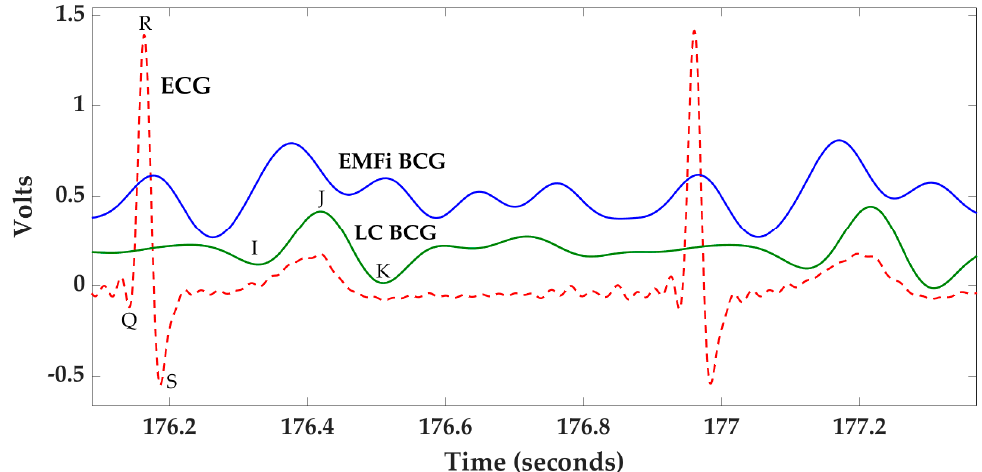
Figure 1. Two sample ballistocardiograms (BCGs) acquired with a bed system using electromechanical film and load cell sensing technologies along with a time-aligned electrocardiogram. The BCG signals have been scaled/shifted vertically. ECG: electrocardiogram; LC BCG: load cell BCG; EMFi: electromechanical